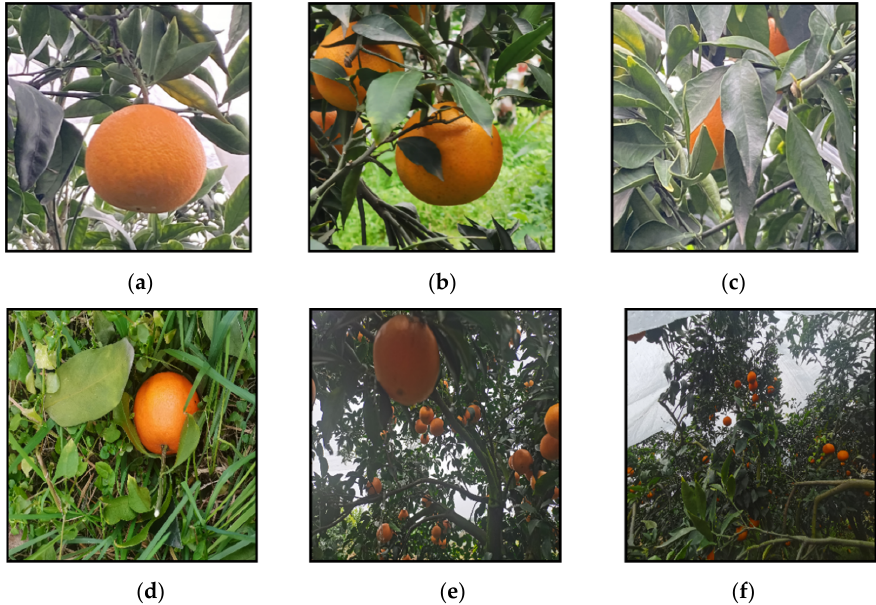
Figure 4. Part of the dataset is shown. ( a ) Single fruit; ( b ) Multiple fruits; ( c ) High degree of occlusion; ( d ) Different background conditions; ( e ) Low light; ( f ) Dense fruit aggregation.